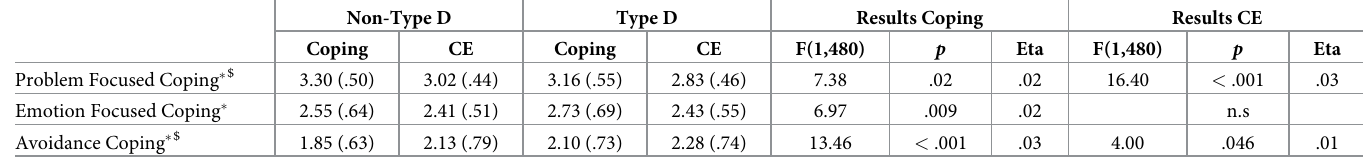
Table 2. Mean and standard deviations for each of the coping dimensions and coping effectiveness (CE) for the Type D and non-Type D participants and results of the analysis of variance (significant results only).